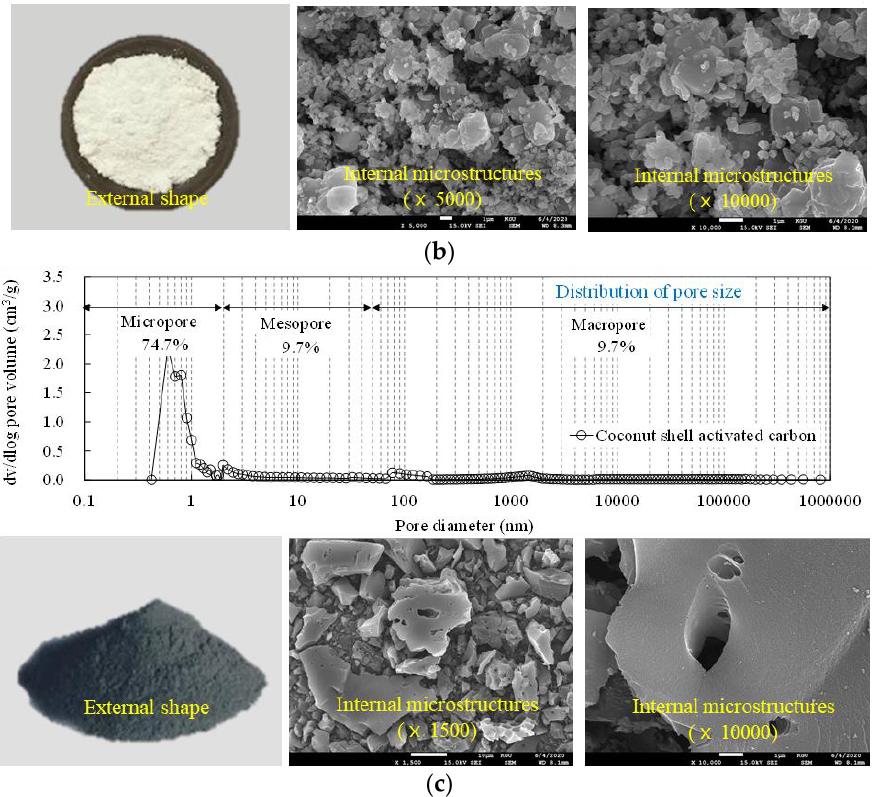
Figure 1. Internal microstructure and pore distribution of each material used. ( a ) Textile fabrics. ( b ) Zeolite. ( c ) Coconut shell activated carbon.